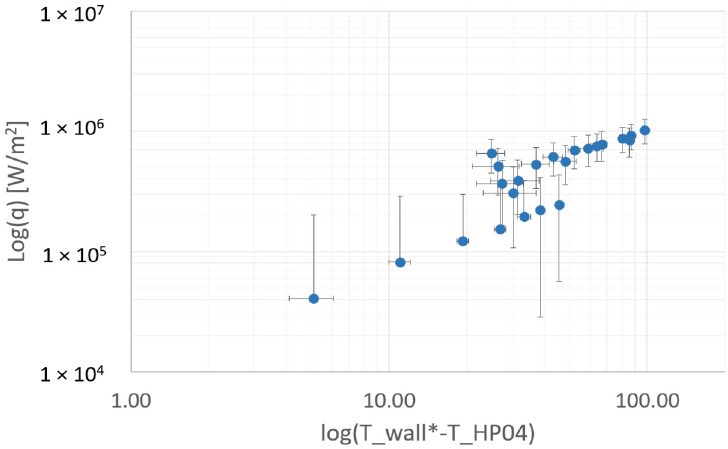
∆ T of mock-up 1 with